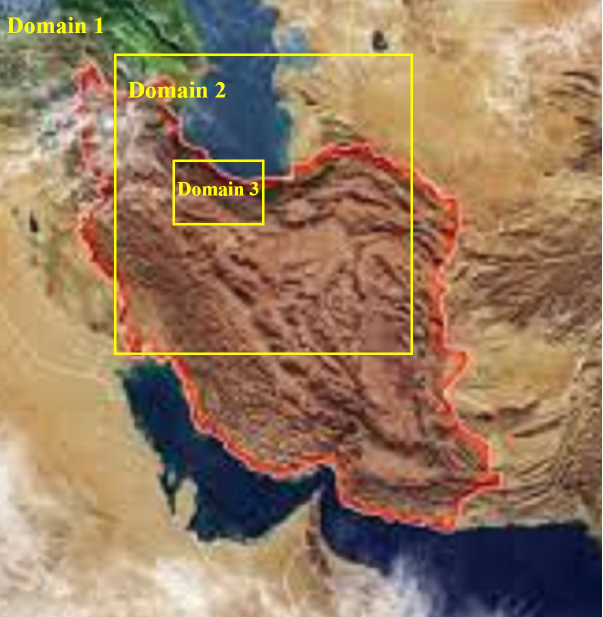
Figure 3. WRF domain setup using an interactive nested domain inside the parent domain.